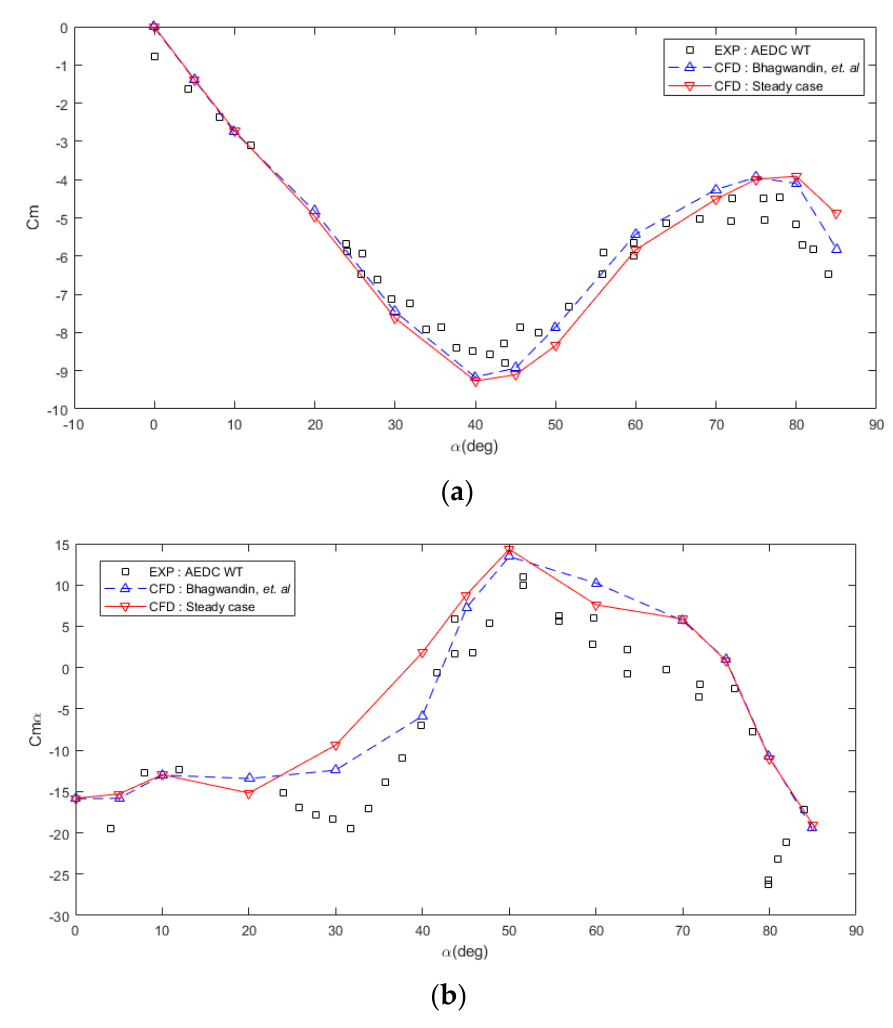
Figure 11. Moment coefficient value for steady analysis alpha sweep from 0 to 85 deg: ( a ) C m vs. α ; ( b ) C m vs. α (cid:3328)